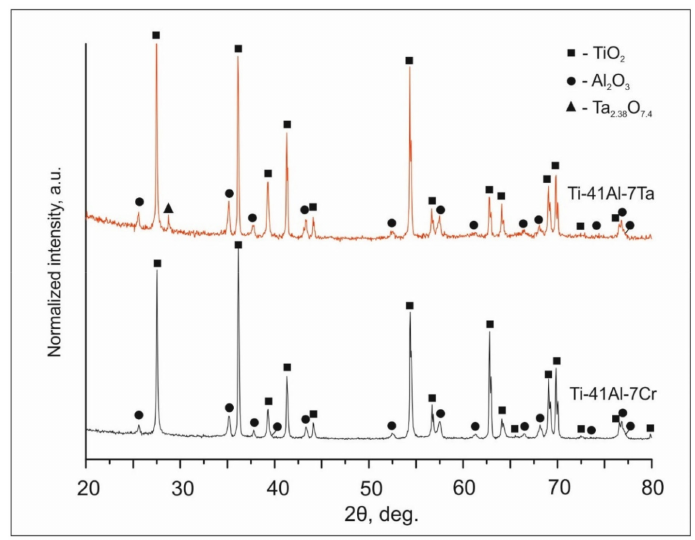
Figure 10. Results of XRD analysis of an oxide scale formed after oxidation at 800 ◦ C for 200